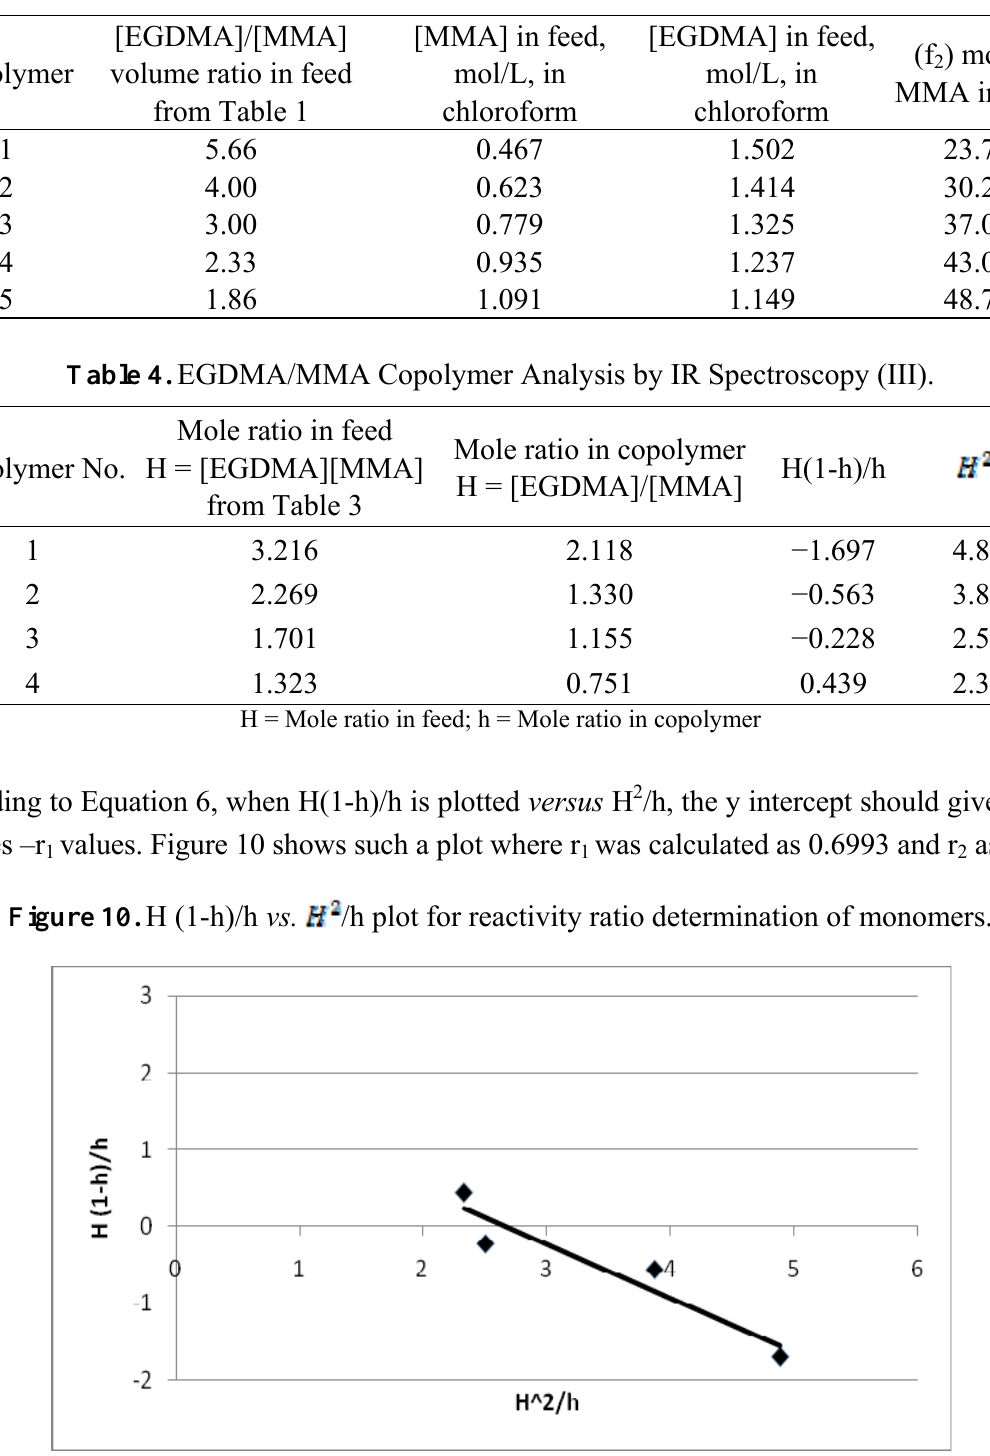
Table 3. EGDMA/MMACopolymer Analysis (II) by IR Spectroscopy.